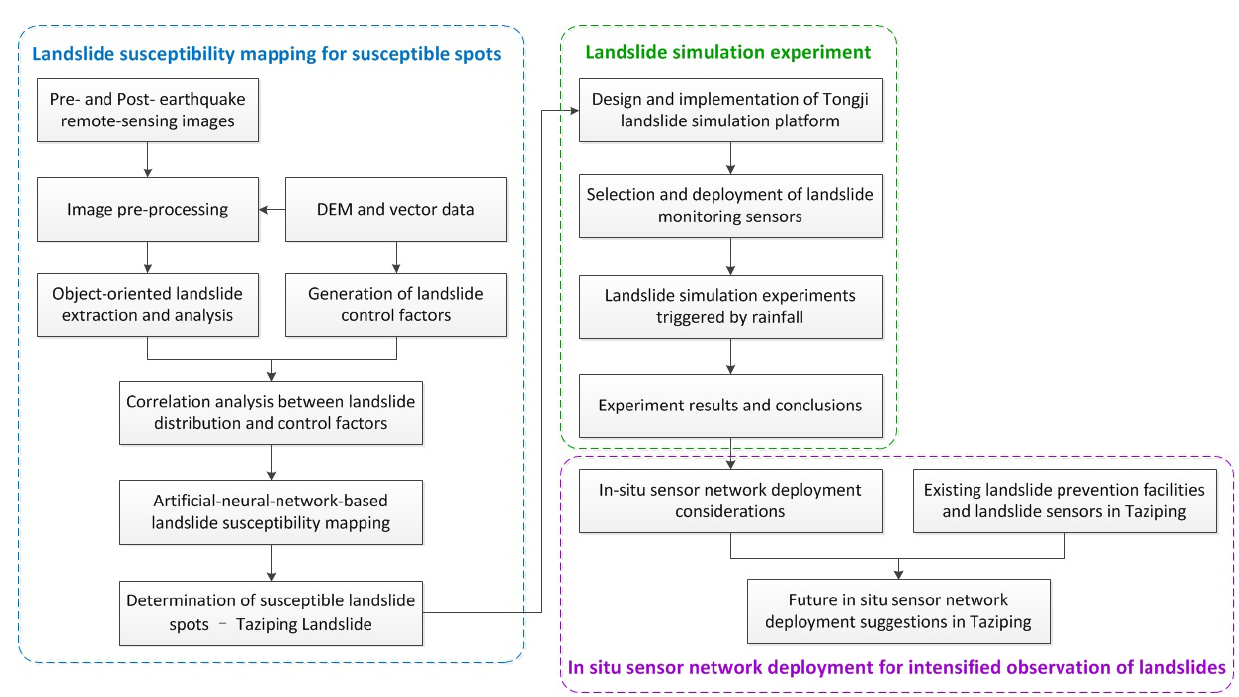
Figure 2. Flowchart of the research approach.